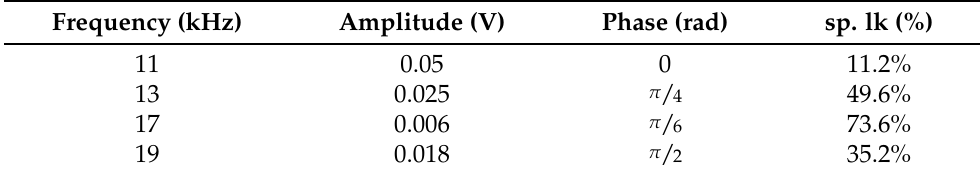
Table 6. Chosen Signal Properties as a Test